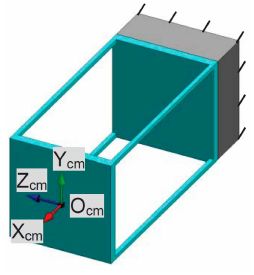
Figure 9. An FBCM and its coordinate